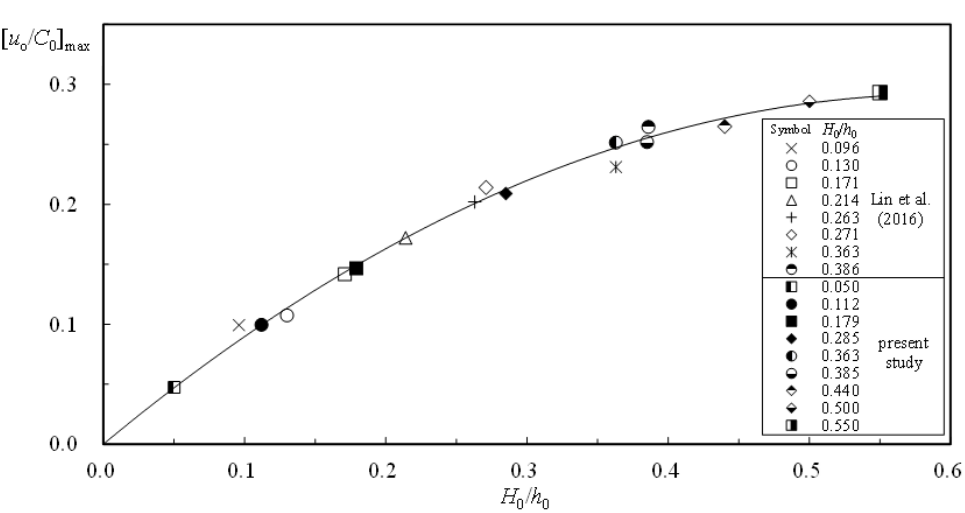
Figure 12. A comparison of temporal variations in the dimensionless free-stream velocity for H 0 / h 0 = 0.050–0.550.